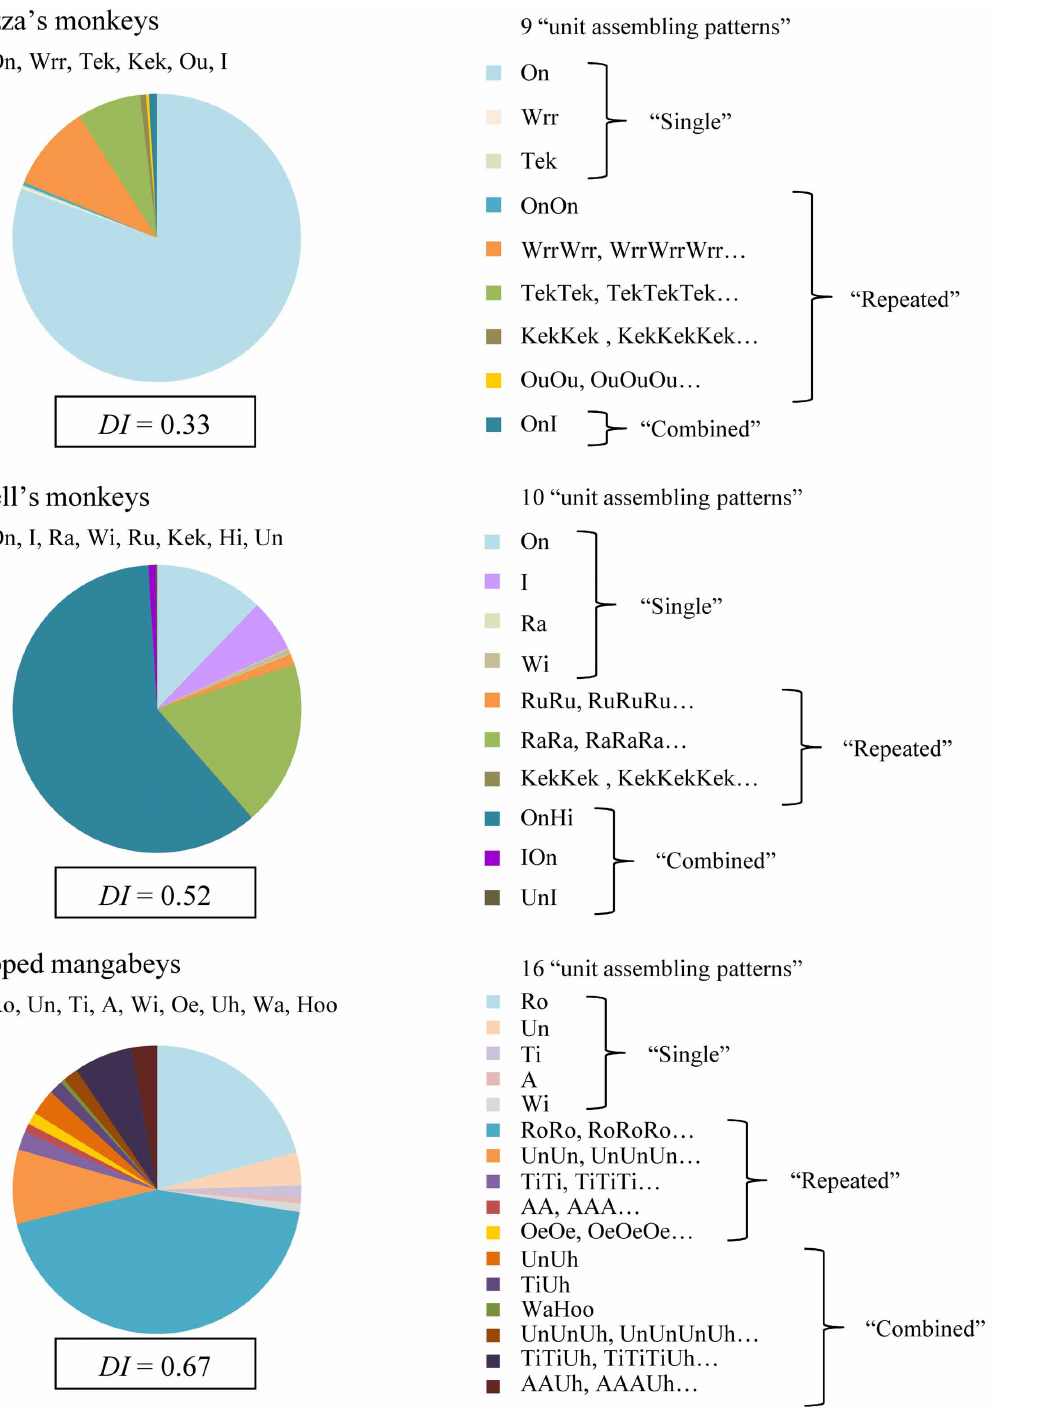
Hausberger (2011) is as follow: “On” = SH; “I” = ST; “Ra, RaRa, RaRaRa ...” = RRA; “Wi” = SA; “RuRu, RuRuRu ...” = RRC; “KekKek, KekKekKek ...” = RSA; “OnHi” = CH; “IOn” = CT; “UnI” = RST. On the right-hand side: all the unit assembling patterns observed, grouped as “single”, “repeated”, “combined” (see the Data Analysis section for definitions). Below each diagram: DI , diversity index (Shannon and Weaver, 1949). The smaller the value of DI , the less diverse the